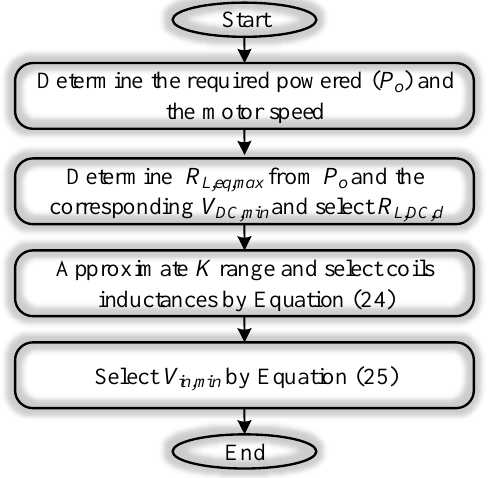
Figure 7. Adopted WPTS design procedure for MDS.